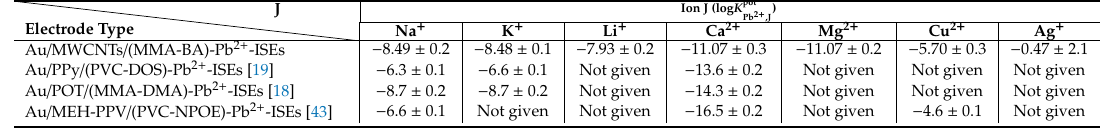
) and interfering ions, including Na + ( ∗ ), K + ( ), Ag + (cid:35) (cid:51) ) of the proposed Pb 2 + ,J